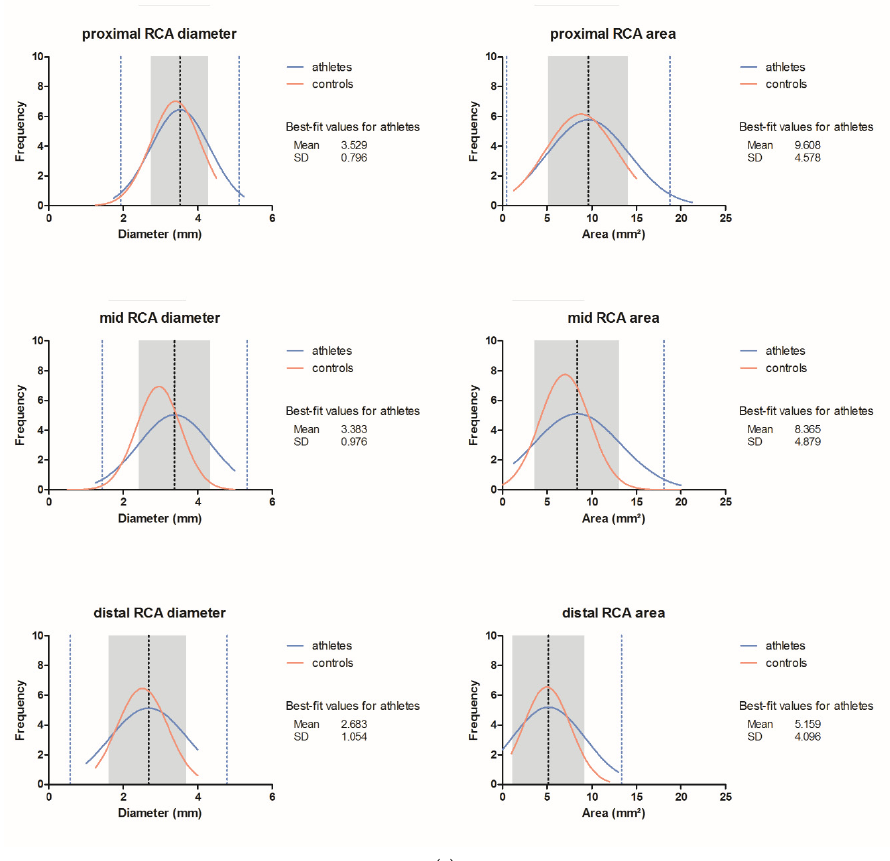
Figure 2. Coronary vessel dimensions (mean diameter and area): normal values for athletes and controls. Dashed lines ± 2 SD (lower and upper border) and ± 1 SD (inner grey zone) ; blue line = athletes ; red line = controls; ---- best fit value. ( a ) Left main (LM) and circumflex (CX) artery; ( b ) Left anterior descending (LAD); ( c ) Right coronary artery (RCA).